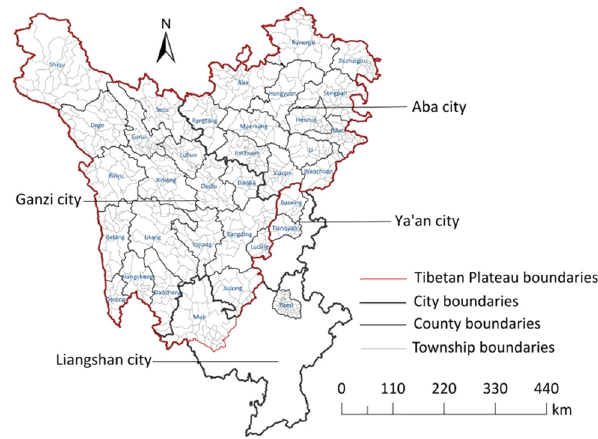
Figure 1: The distribution map of ethnic minorities in Sichuan [ 6 ] .